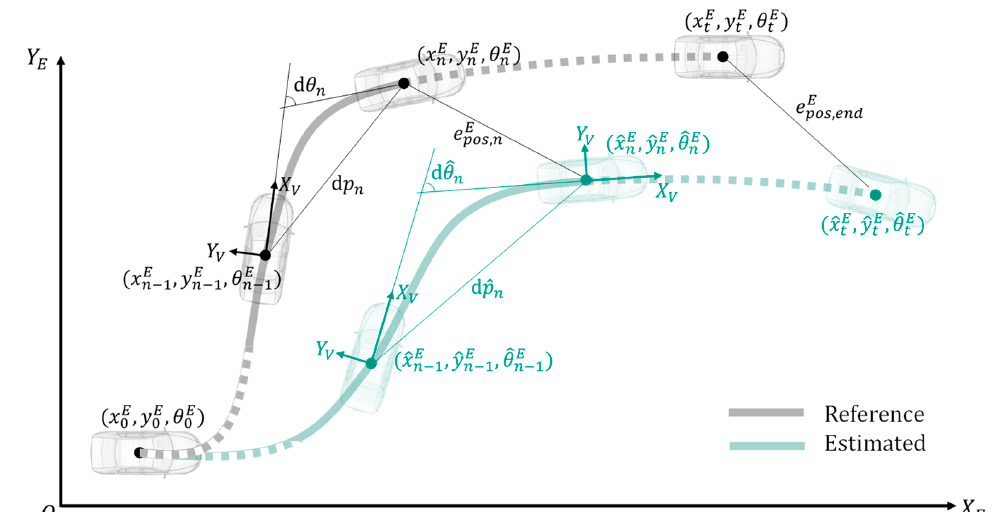
Figure 17. Schematic illustration of evaluation criteria.